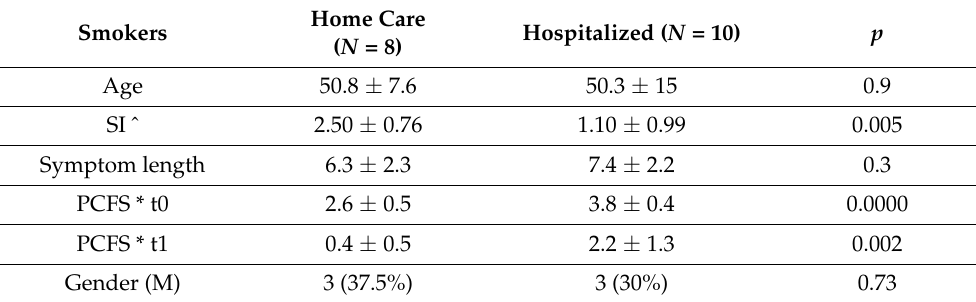
Table 4. Clinical Characteristics of HSm and NhSm groups treated with